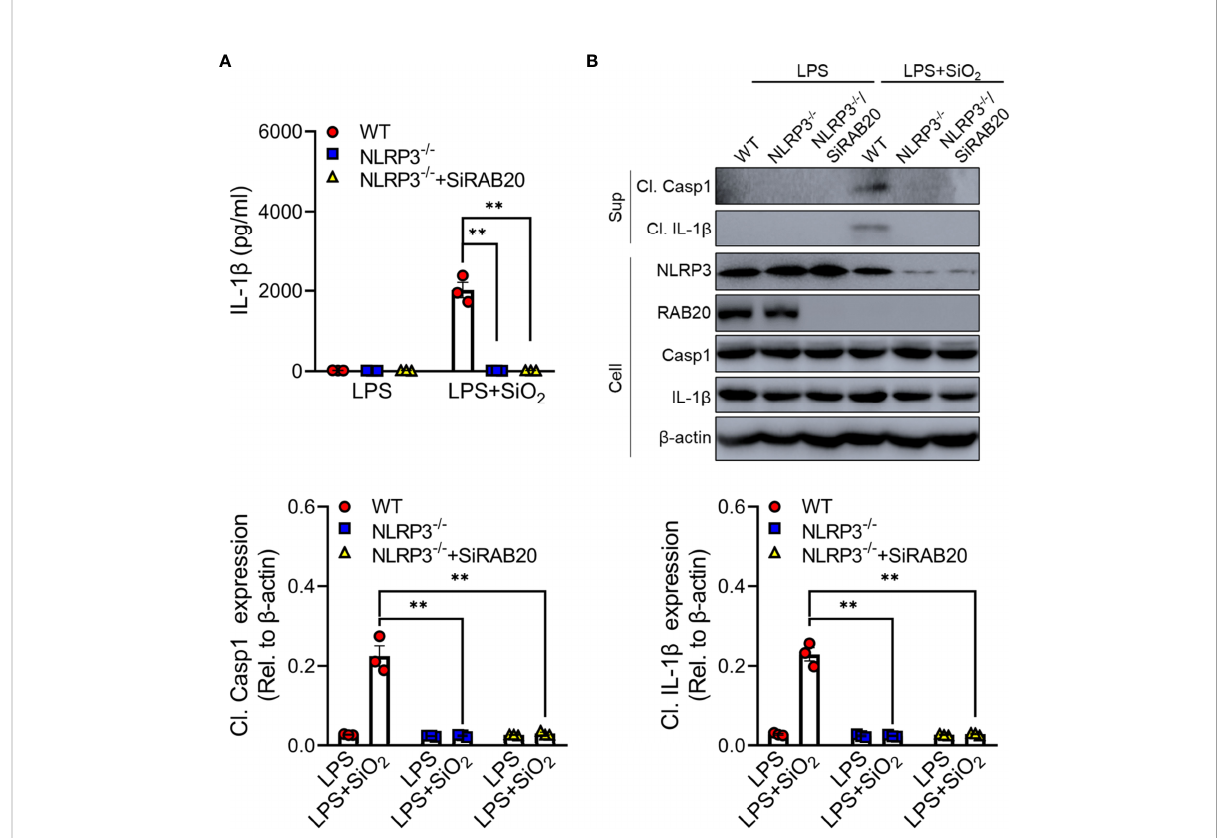
FIGURE 4 Knockout of NLRP3 blocks RAB20 de fi ciency-induced proin fl ammatory cytokine release (A) IL-1 b secretion in wild type, NLRP3 knockout, and NLRP3 knockout/RAB20 knockdown peritoneal macrophages stimulated with SiO 2 after LPS priming. (B) Immunoblotting for IL-1 b , caspase-1, NLRP3, and b -actin in the supernatants (SN) or cell lysates (cell) of wild type, NLRP3 knockout, and NLRP3 knockout/RAB20 knockdown mouse peritoneal macrophages stimulated with SiO 2 after LPS priming. **p < 0.01 (unpaired/two-tailed t test, one-way and two-way ANOVA test). Data are shown as mean ± SEM from three independent